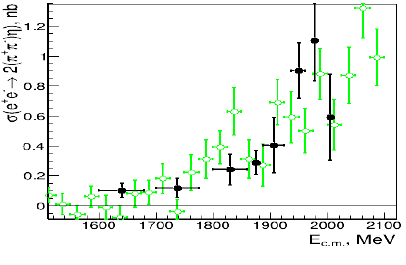
Figure 12. The e + e − → 2( π + π − ) η cross sec- tion measured with the CMD-3 detector at VEPP- 2000 (circles). The results of the BaBar measure- ment are shown by open